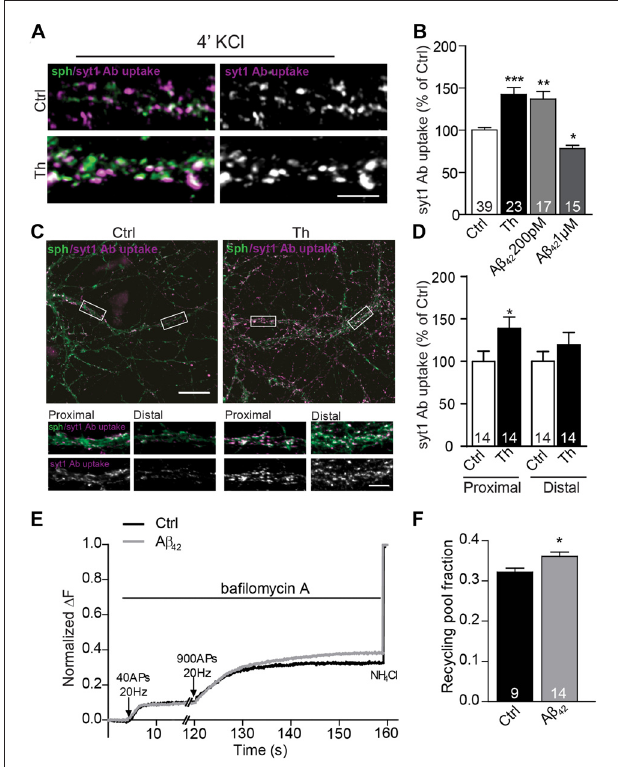
FIGURE 3 | Picomolar A β increases the size of the functional recycling pool. (A) Representative images of depolarization-induced syt1 Ab uptake in control and Th-treated neurons. (B) Quantification of evoked syt1 Ab uptake after application of Th and pM or µ M A β 42 . Numbers represent the number of cells used for analyses derived from three (Th) and two (A β ) independent cultures. (C) Representative images of syt1 Ab uptake from control or Th-treated hippocampal neurons contacting proximal as well as distal dendritic segments. Proximal and distal areas where the boutons were analyzed are boxed. (D) Quantification of the data in (C) . Values within columns correspond to the number of analyzed visual fields pooled from two independent cultures. (E) Averaged traces from hippocampal cells expressing sypHy and treated with control or 200 pM A β 42 . Intensities are normalized to the maximal NH 4 Cl response. (F) Mean values of the recycling pool. Numbers within columns represent the number of the analyzed cells from at least three independent cell culture preparations. Values are expressed as the mean ± SEM. Statistical significance was assessed by Kruskal-Wallis test followed by Dunn’s multiple comparison test (B) , unpaired two-tailed Student t test (D) or Mann Whitney test (F) ∗ p < 0.05, ∗∗ p < 0.01, ∗∗∗ p < 0.001. Scale bars are10 µ m in overview and 5 µ m in insets.